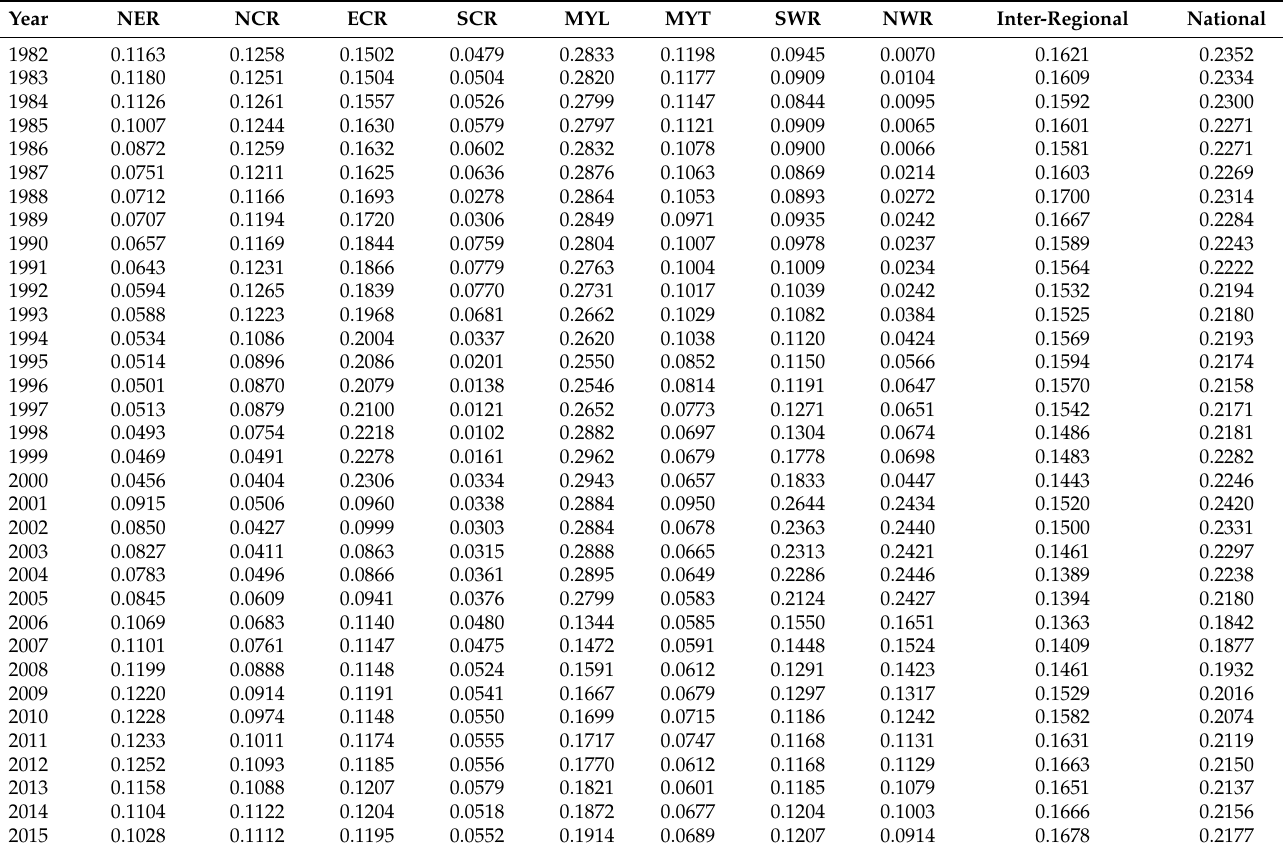
Table A1. National, regional, and inter-regional Gini